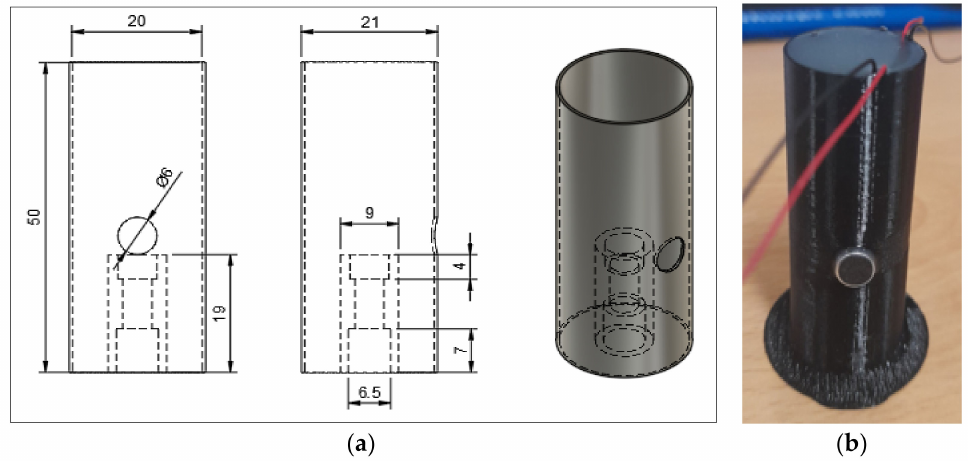
Figure 5. Microphone case drawing ( a , b ) case filled with PDMS. After designing the microphone case, its resonance frequency was measured in the frequency range of interest using Laser Doppler Vibrometer and the acoustic excitation method. It was found that the resonance peak was at a frequency of 57 Hz, as shown in Figure 6.